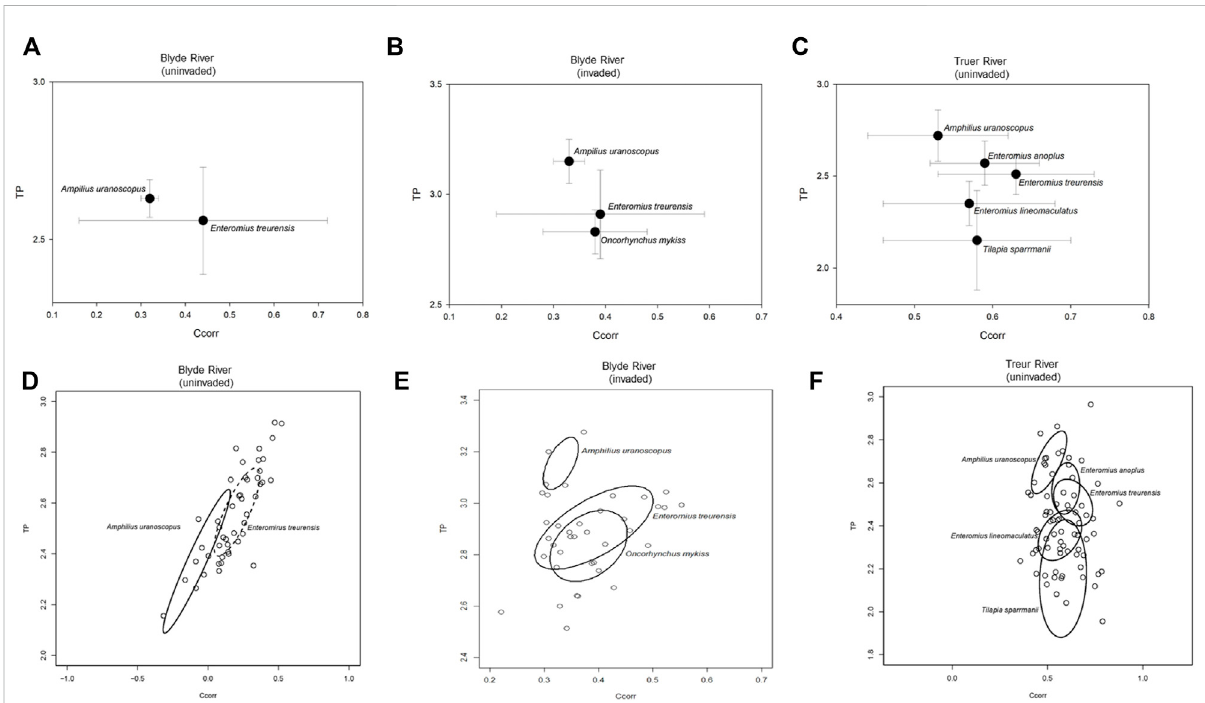
FIGURE 2 Centroid positions, and estimates of niche size and overlap using sample size-corrected standard ellipse areas (SEAc) of fi sh species sampled from sites invaded by rainbow trout ( Oncorhynchus mykiss ) on the Blyde River (B,E) and sites free of invasion both the Blyde (A,D) and Treur rivers (C,F)